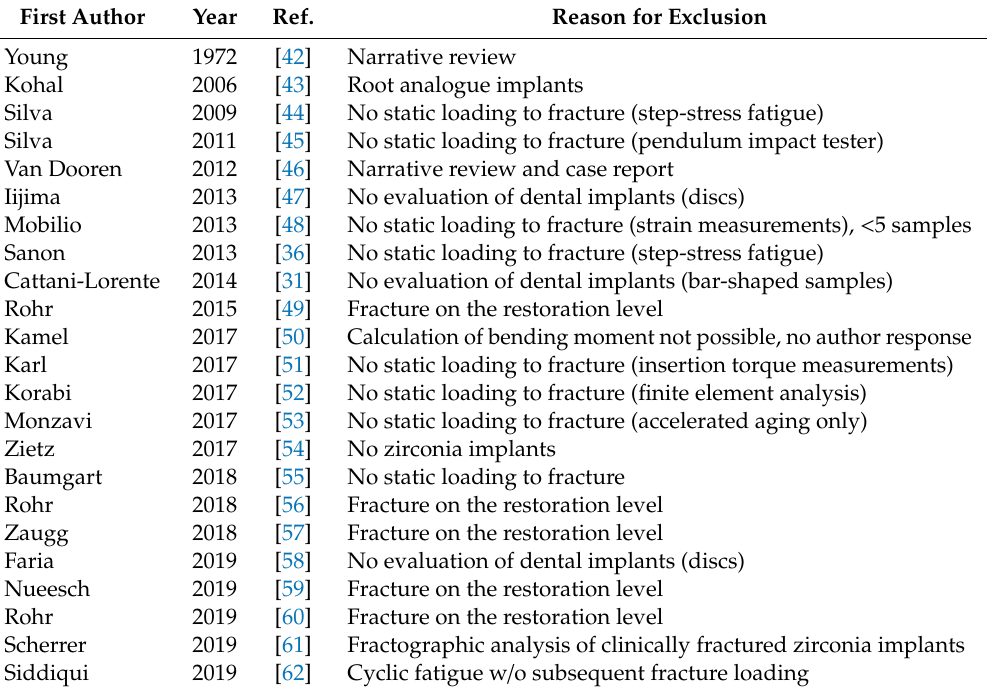
Table A1. Articles excluded after screening of the